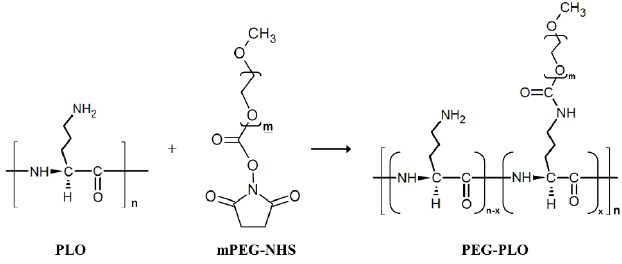
Figure 1. Synthesis scheme of polyethylene glycol modified poly- L -ornithine (PEG-PLO) using N -hydroxysuccinimide (mPEG-NHS). PLO and mPEG-NHS were mixed in a 1:10 molar ratio. The mixture was stirred overnight at room temperature